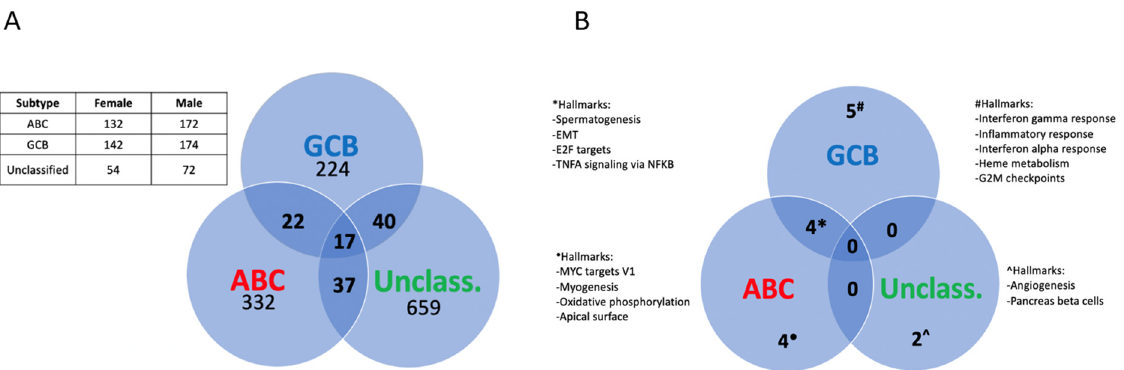
Figure 2. Sex differences in gene expression and pathways among molecular subtypes of DLBCL. ( A ), Venn diagram showing the distribution of the differentially expressed genes among the DLBCL subtypes (adj. p -value < 0.05). The table shows the number of samples for each subtype and sex. ( B ), Venn diagram depicting the significant pathways showing a sex difference among the DLBCL subtypes as analyzed by GSEA (adj. p -value < 0.05).